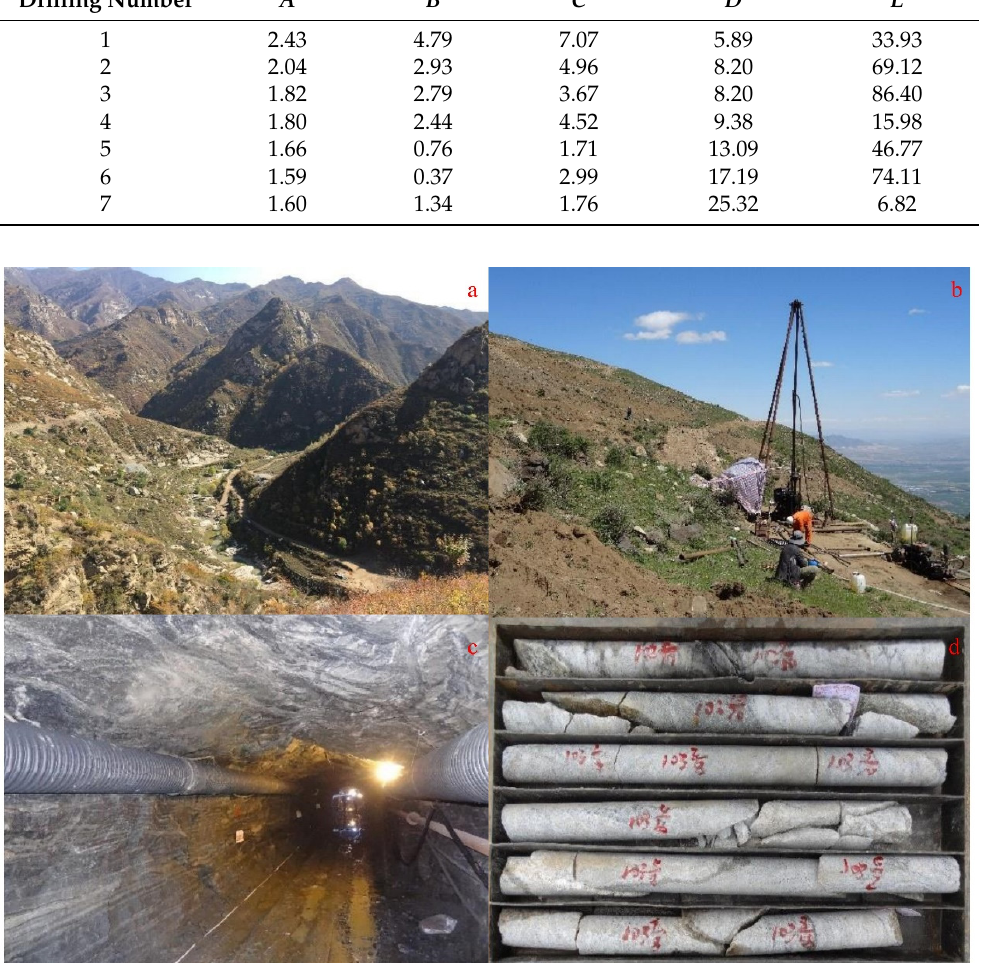
Figure 3. Survey and drilling schematic of hydropower station. ( a ): topography of the project area; ( b ): drilling of the high-pressure pipeline; ( c ): hole-detecting of the powerhouse; ( d ): photograph of rock cores.